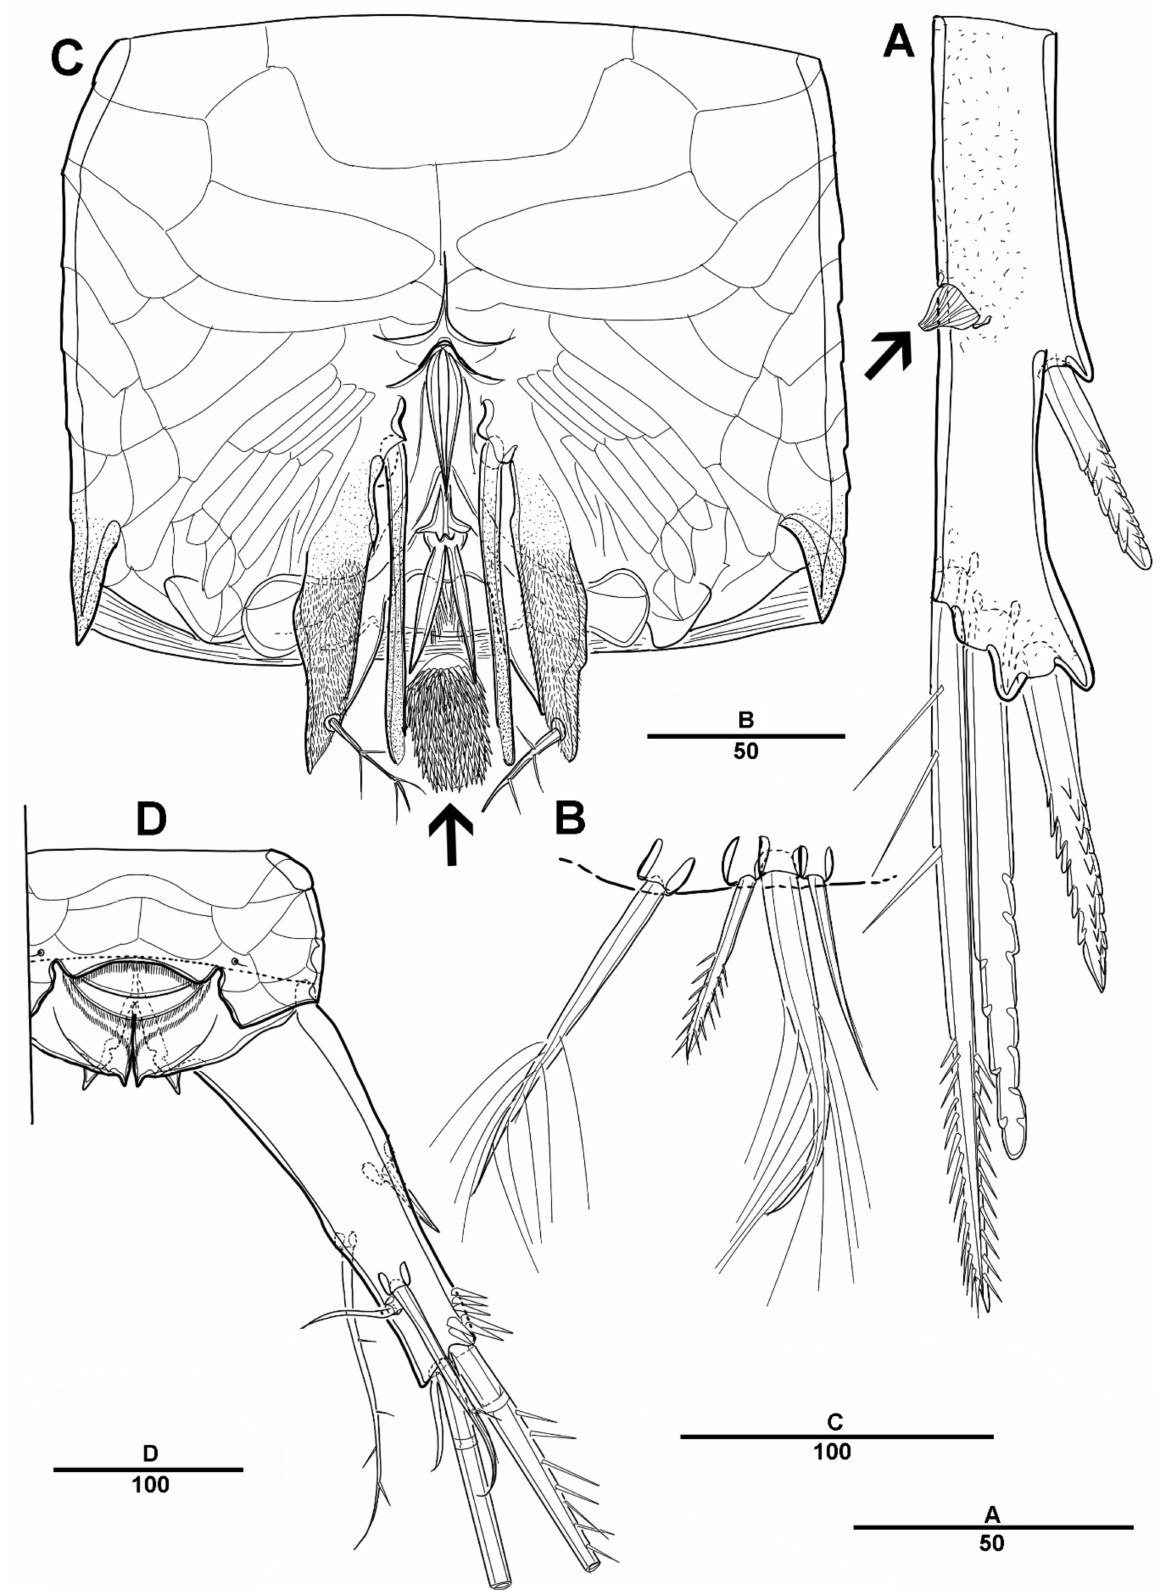
Figure 21. Scottolana wonchoeli sp. nov. paratype male: ( A ) P3 enp-3, anterior (modified pore arrowed); ( B ) P5; ( C ) genital somite, ventral (patch of dense spinules arrowed); ( D ) anal somite and right caudal ramus, dorsal. Scale bars in µ